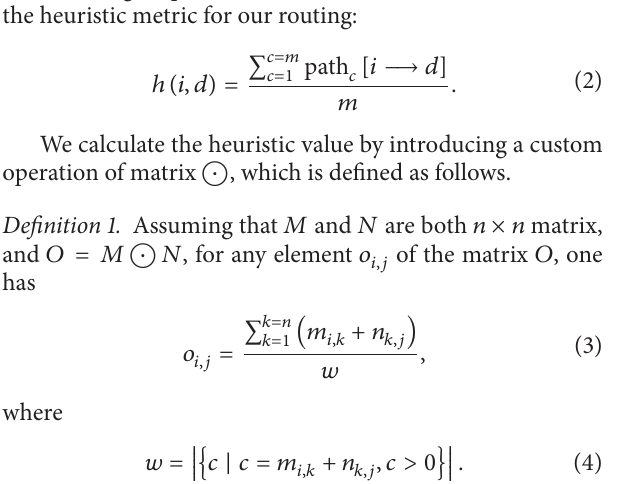
Algorithm 2: Heuristic value calculation.